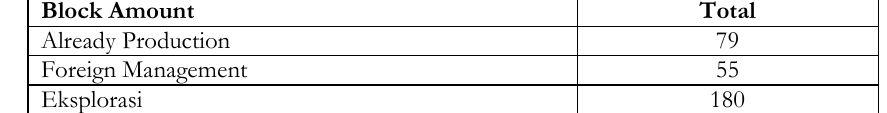
Control of the Oil and Gas Block in 2014-2019 Block Amount Total Already